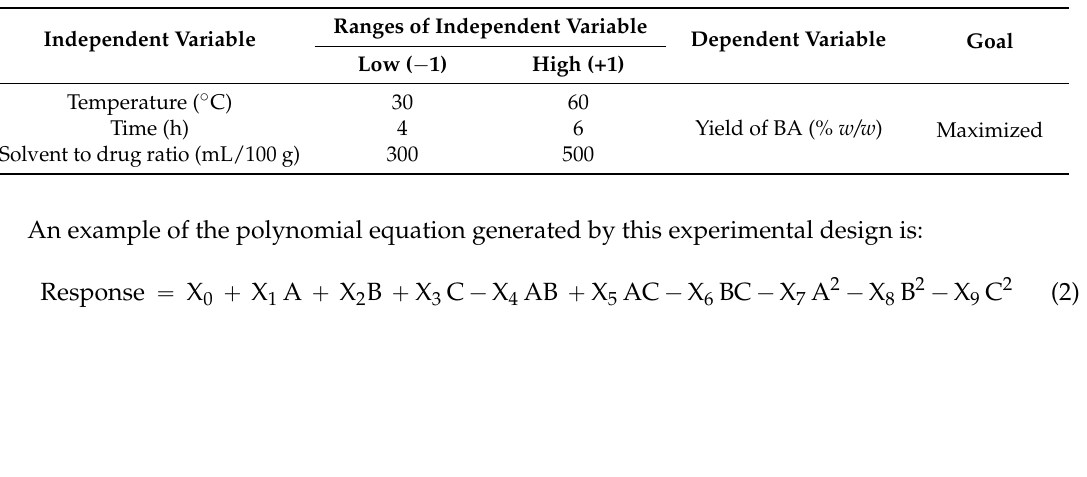
Table 9. Extraction variables selected for BBD